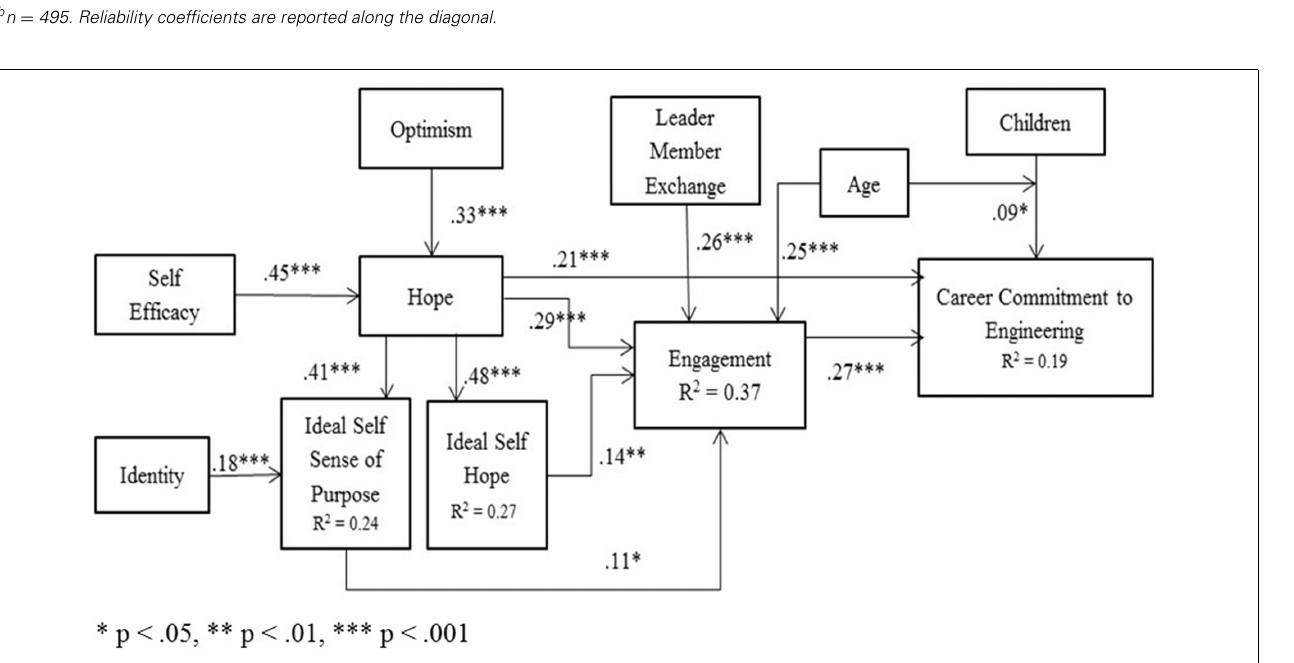
Convergent and discriminant validity were established using the criteria from Hair et al.